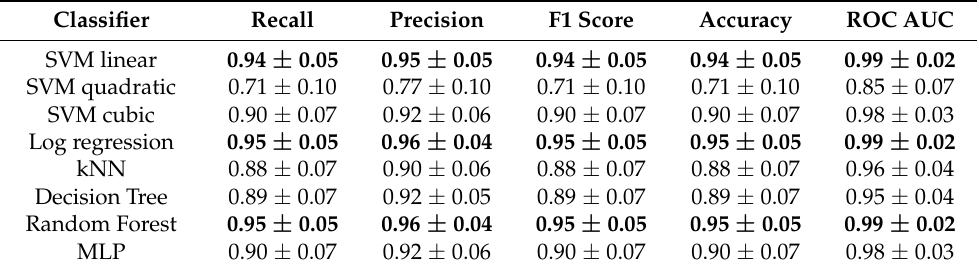
Table 2. Main classification performance measures obtained for a complete feature set.